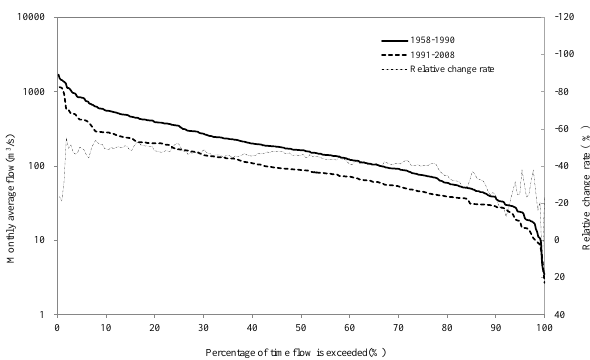
Figure 4. Flow duration curves under different periods in the Wei River